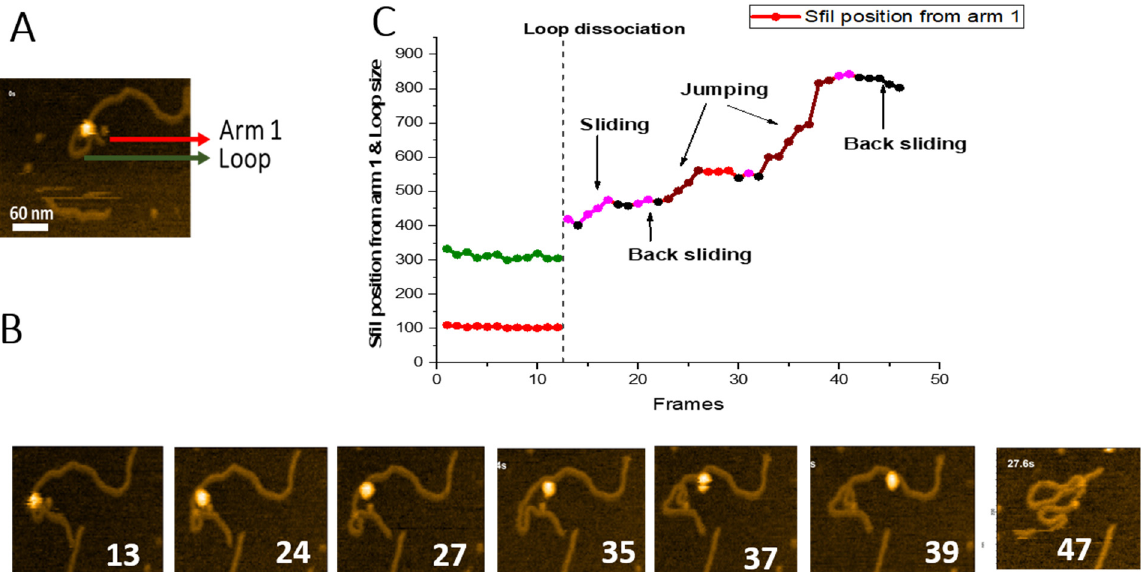
Figure 6. Sliding and jumping of SfiI tetramer after loop dissociation. ( A ) Initial frame of the Movie S5. SfiI tetramer can be seen as a bright feature at the center of the loop structure. The loop is indicated with a green arrow, the small DNA arm (Arm 1) is labeled with a red arrow. ( B ) HS-AFM movie frames with important events between frames 1 and 46; numbers indicate frames. The frames show dissociation of the complex and translocation of the SfiI tetramer along the DNA. ( C ) Graph showing the position of the SfiI tetramer along the length of the DNA measured in base pairs (bp) ± SE. The blue line indicates the length of the DNA Arm 1. The vertical dotted line indicates loop dissociation. The different events observed during were indicated with different colors, as shown in the graph.